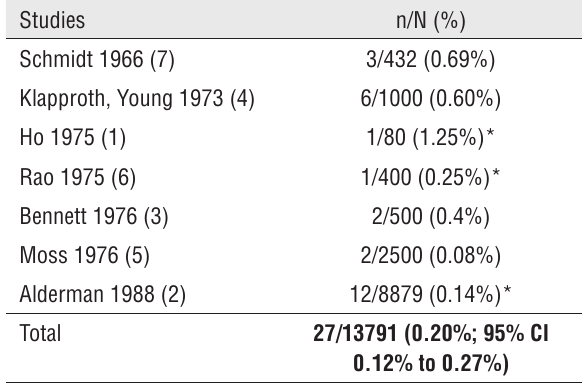
Table 2 - Prevalence of unilateral absence of vas deferens in published case series of men seeking